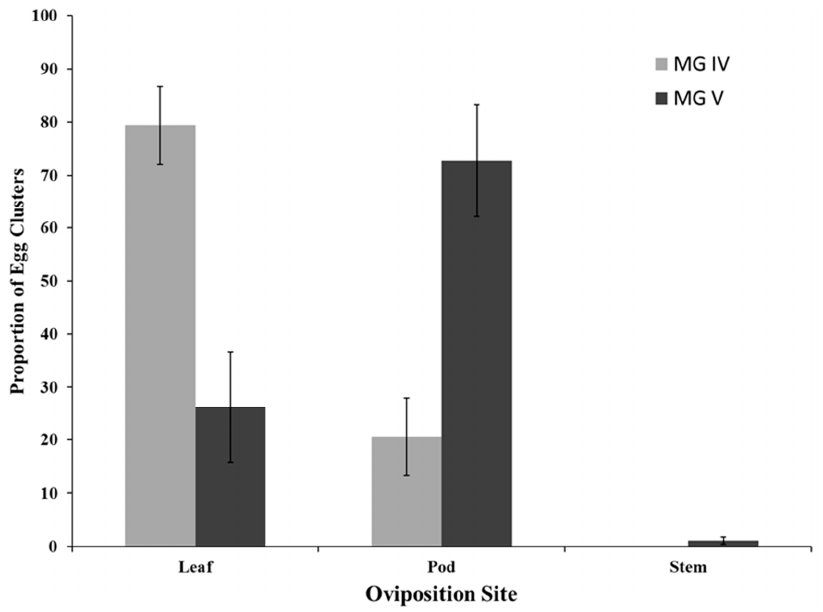
Figure 1. Frequency of redbanded stink bug egg clusters by oviposition site within MG IV and MG V soybeans.